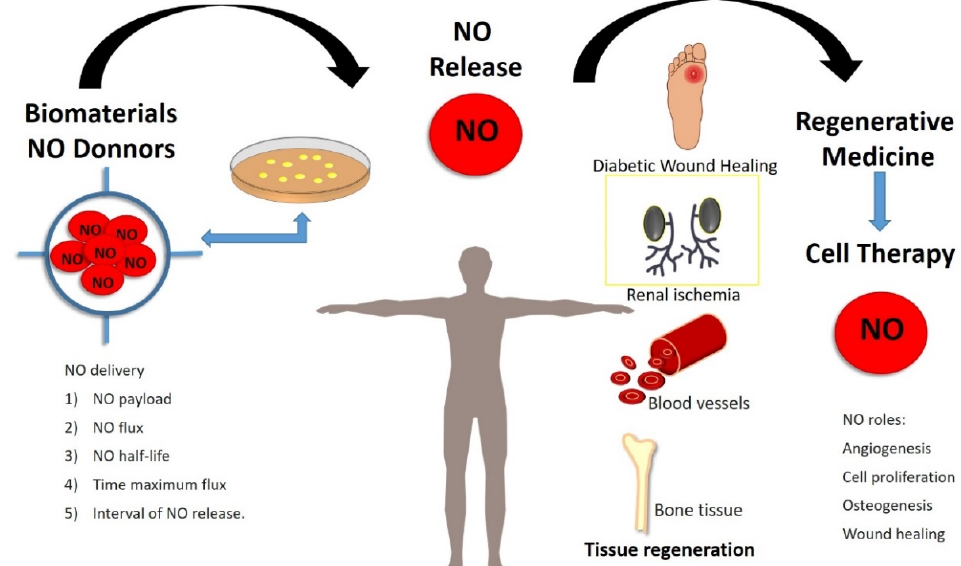
Figure 3. Exogenous nitric oxide (NO) treatment in regenerative medicine. Recently, several